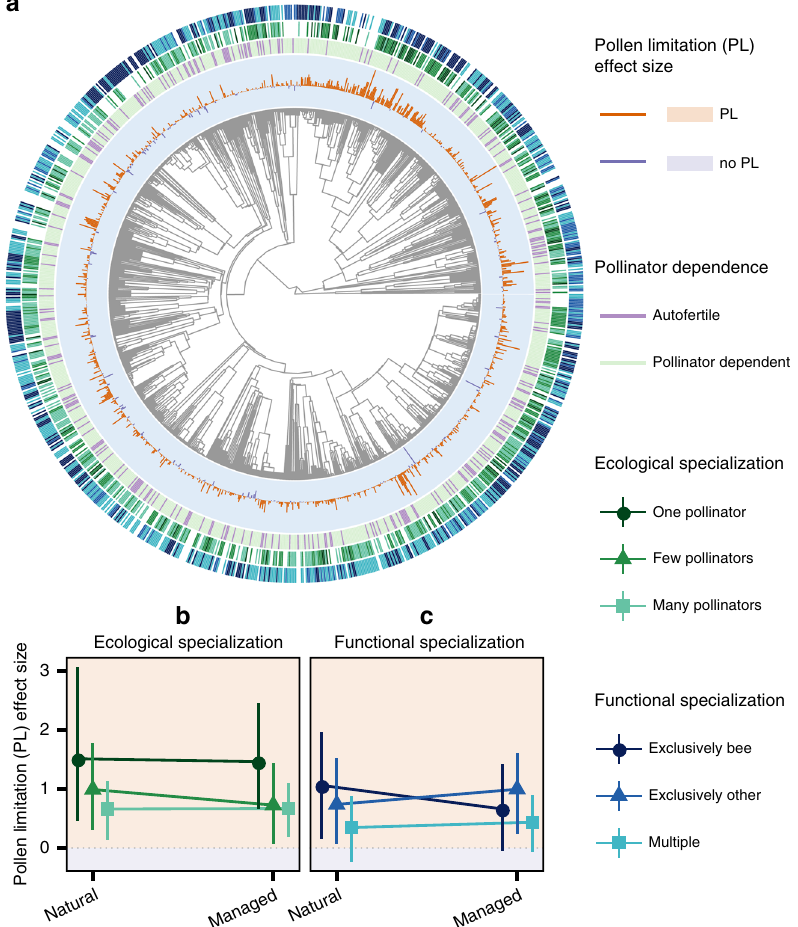
Fig. 2 Phylogenetic distribution of data extracted from the GloPL database 17 (a) and interaction plots of the interaction between land use and ecological specialization (b) and land use and functional specialization (c) in respect to the effect size of pollen limitation (PL). The phylogeny is modi fi ed from the angiosperm supertree 42 and for each species the PL effect size and category of pollinator dependence, ecological specialization, and functional specialization are shown. Pollen limitation effect size in ( a ) is given by a bar plot, where orange bars indicate a positive effect size and dark purple bars indicate an effect size of or below (i.e. no PL). Pollinator dependence of plants in ( a ) is classi fi ed as autofertile (purple) or pollinator dependent (light green). Ecological specialization of plants in ( a , b ) is classi fi ed as reliant on either one (dark green), few (green) or many (light green) pollinator species. Functional specialization of plants in ( a , c ) is classi fi ed as exclusively bee pollinated (dark blue), exclusively pollinated by another functional group (blue) or pollinated multiple functional groups (light blue). Interaction plots represent the average modelled and 95% con fi dence intervals (shown as error bars) result from 500 bootstrapped phylogenetic meta-analyses with pollen limitation as the response variable and the interaction between land use and ecological specialization or functional specialization as the predictor variables. Source data are provided as a Source Data fi